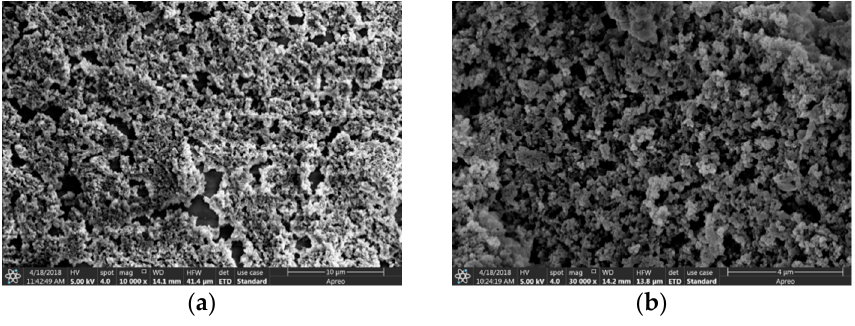
Figure 3. The SEM images of the piezoelectric chip surface modified by RAC imprinted material ( a ) ×10000; ( b ) ×30000 magnification.